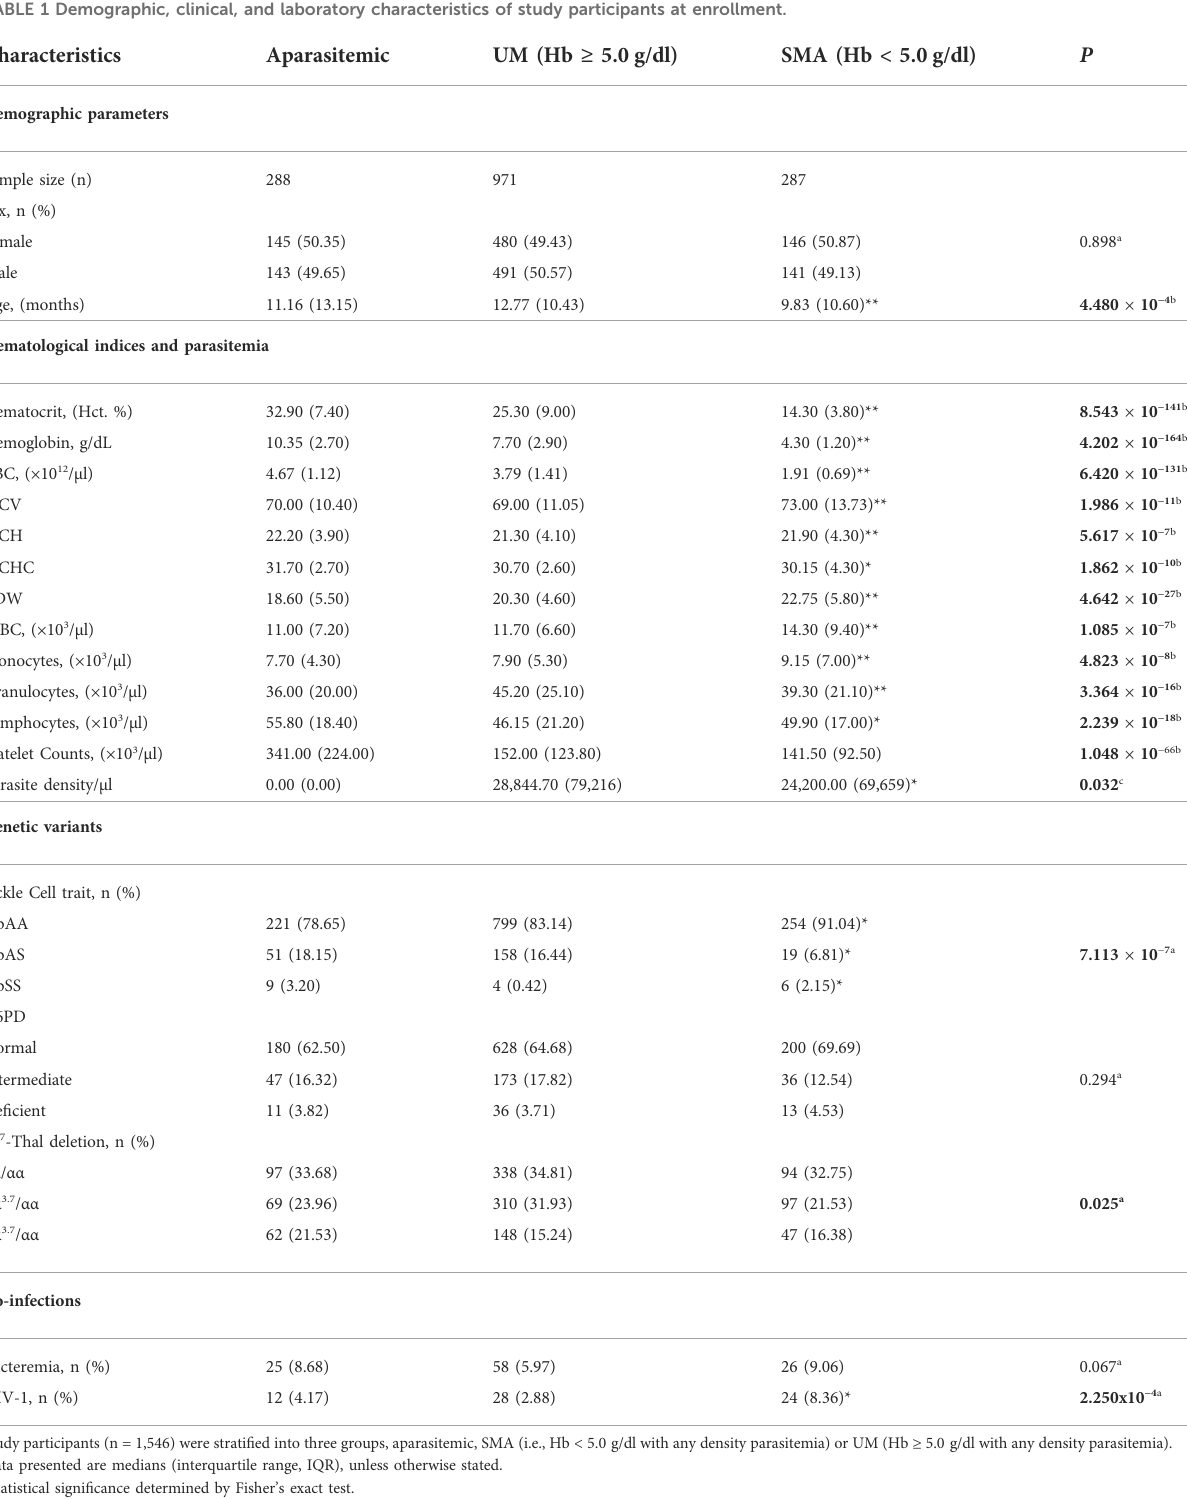
TABLE 1 Demographic, clinical, and laboratory characteristics of study participants at